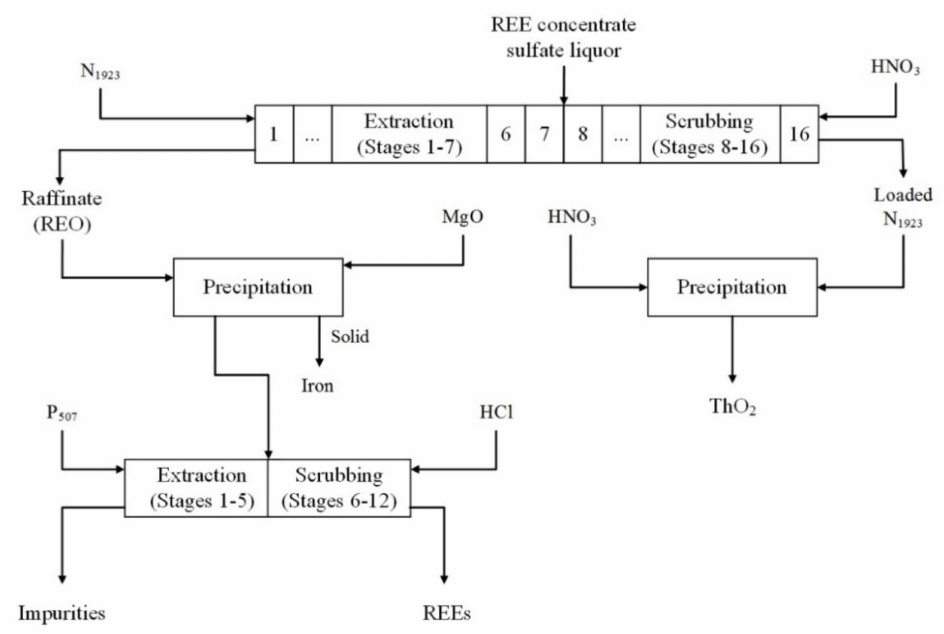
Figure 5. Process of separating Th from REE of Baotou bastnäsite leaching.